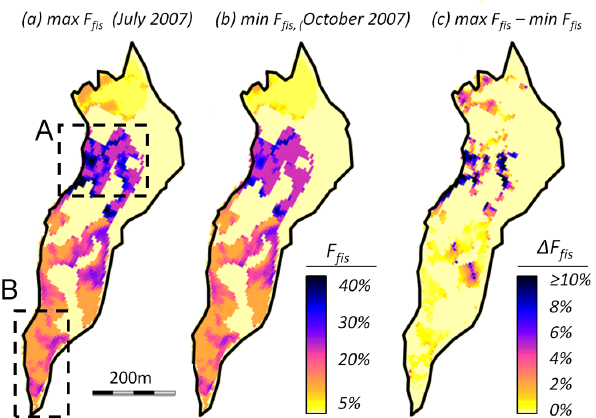
Fig. 8. The modelled dynamics in fissure fraction during: (a) max- imal fissure fraction (max F fis ) , (b) minimal fissure fraction (min F fis ) and (c) the difference between two extremes (max F fis -min F fis ) that occurs during one year simulation period (2007). The ar- eas A and B indicated in Fig. 7a are further discussed.